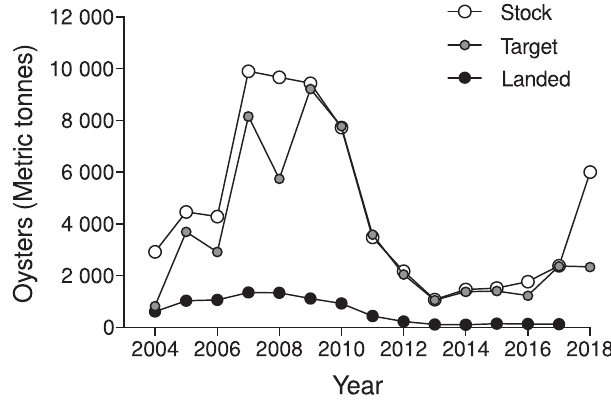
Fig. 3. The annual fl at oyster ( Ostrea edulis ) population size, landings and estimated proportion of target oysters (60 g in 2005 and > 80 g since 2006) during 2004 – 2018 in the Limfjorden, Denmark.